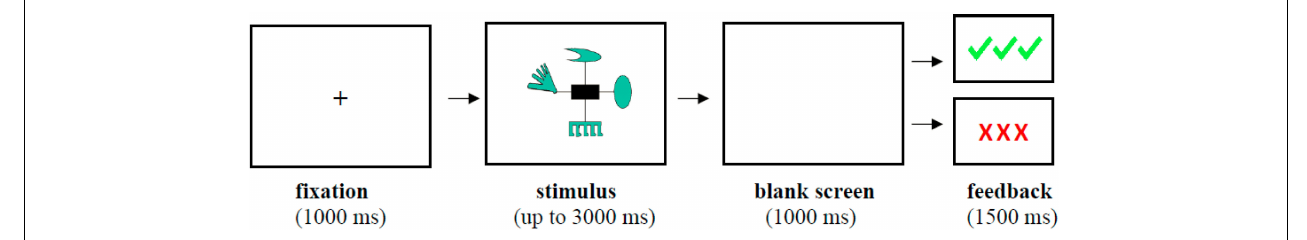
FIGURE 2 | An illustration of a single trial during the training phase of the task.